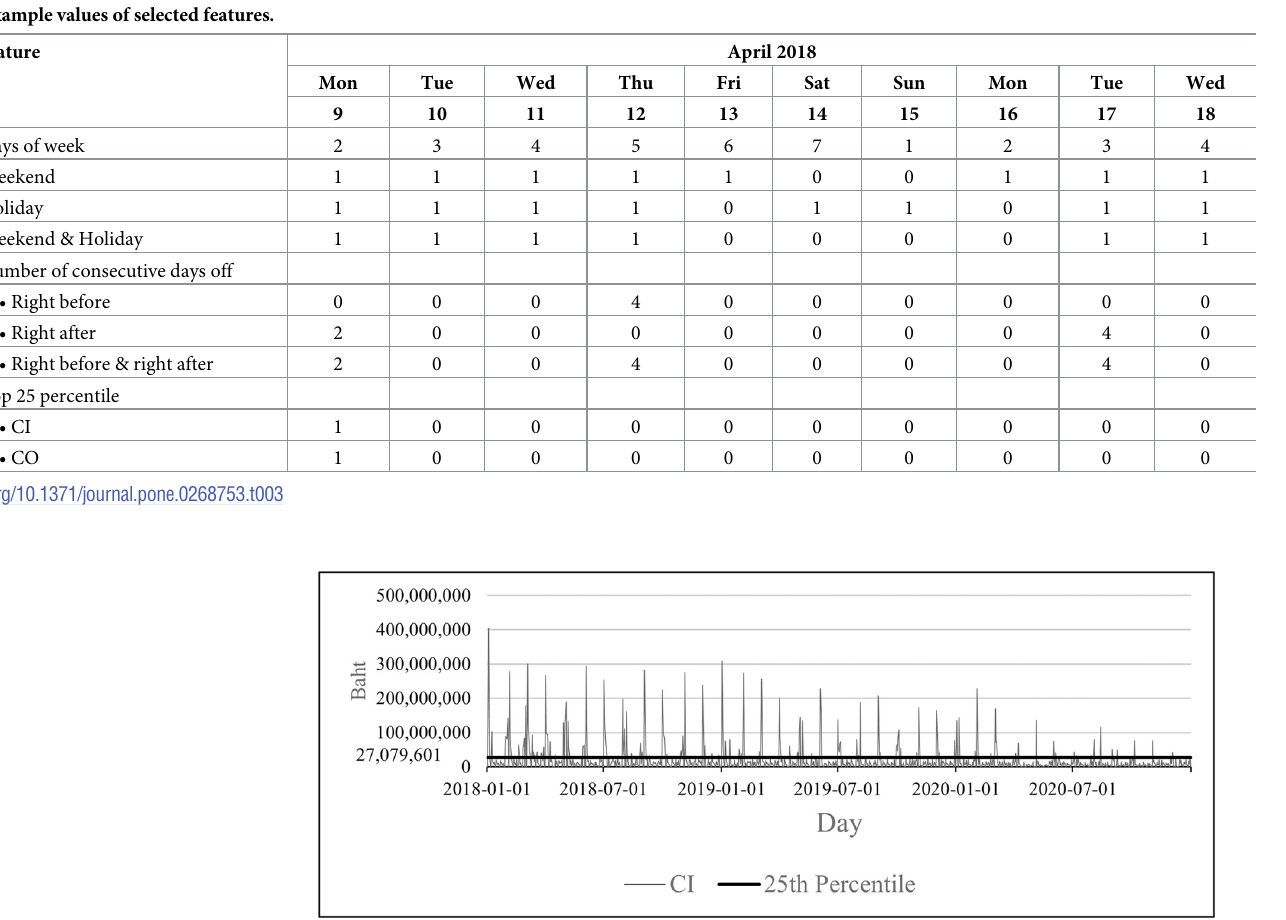
Fig 5. Daily CI in comparison to the 75th percentile of a